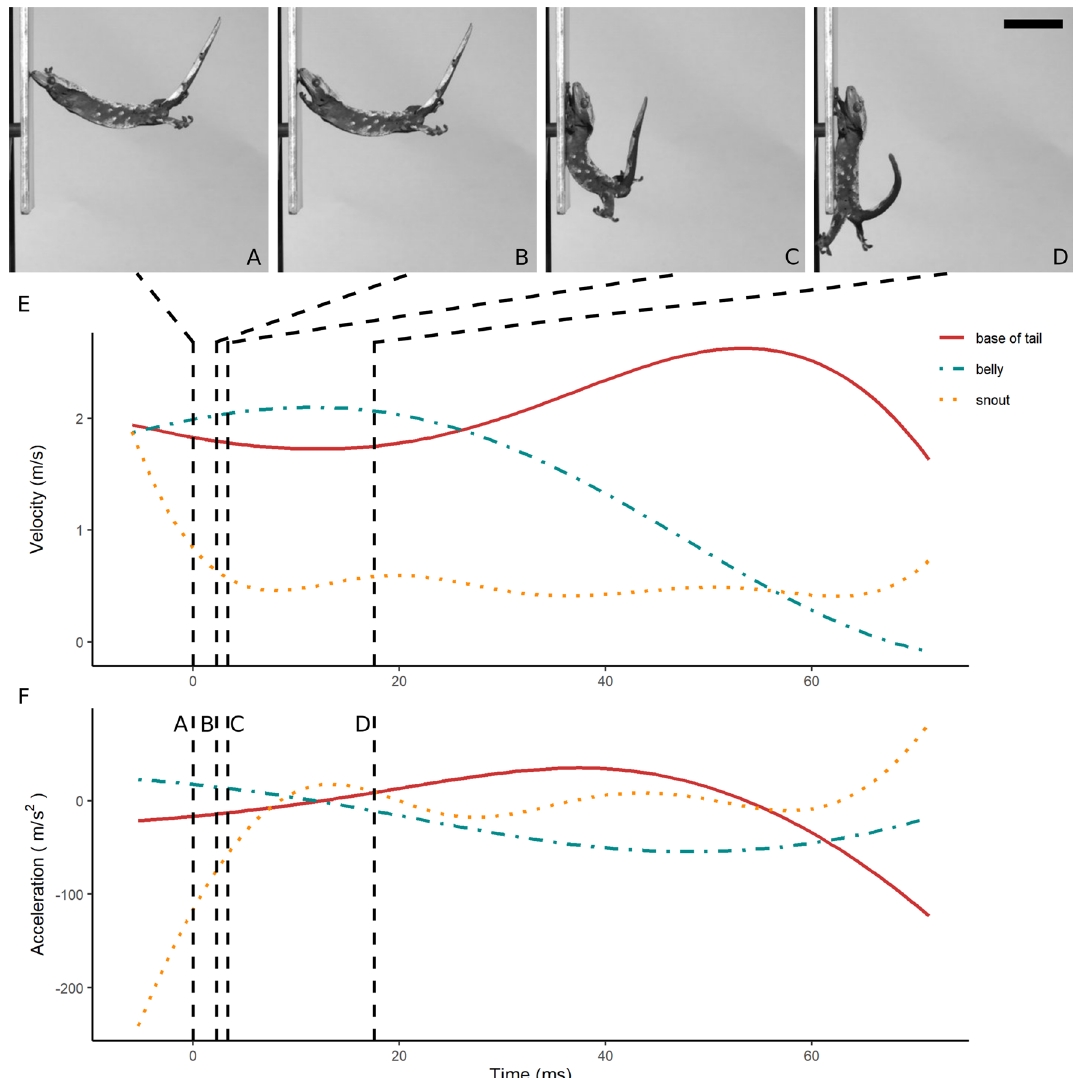
Figure 6. Representative landing process of a gecko jumping onto a vertical platform. ( A – D ) Frames showing the belly ( A ), the snout ( B ), the forelimbs ( C ) and the hindlimbs ( D ) initiating contact with the landing platform. The time point of each frame is indicated on the plot by a vertical dashed line. ( E ) Velocity of snout (yellow dotted line), belly (blue dashed line) and base of the tail (solid red line) during landing. ( F ) Acceleration of snout, belly and base of the tail during landing. Scale bar represents 5